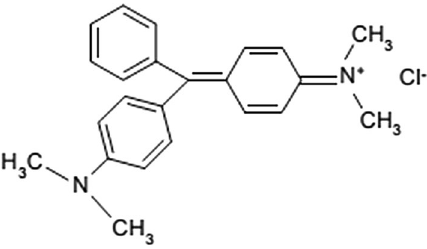
Fig. 1 Structural formula of Malachite Green